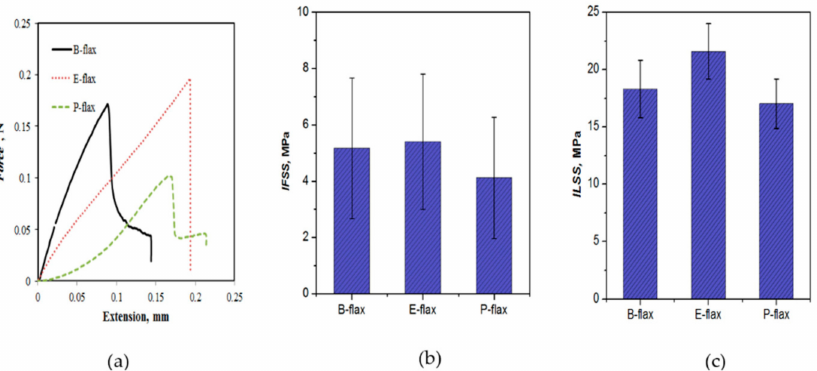
Figure 6. ( a ) Typical force-extension curve in the micro-bond test. ( b ) Interfacial shear strength (IFSS) of flax fiber resin interfaces measured through micro-bond testing. ( c ) Interlaminar shear strength (ILSS) of flax fiber composites with di ff erent resin